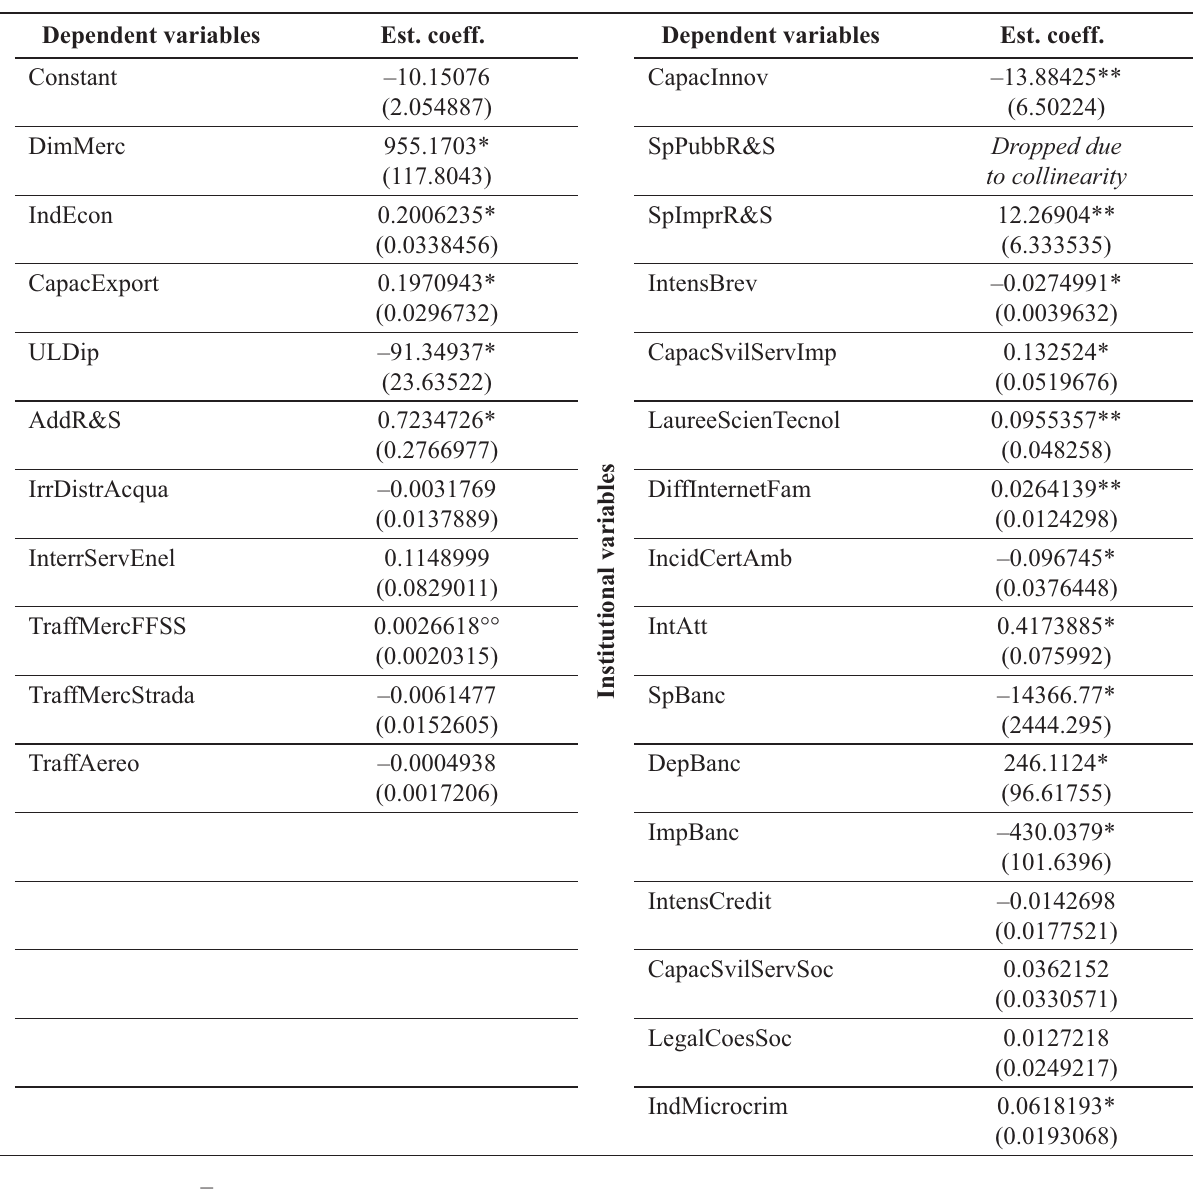
Table 5. Estimation results of the FGLS model (dep. var.: ln